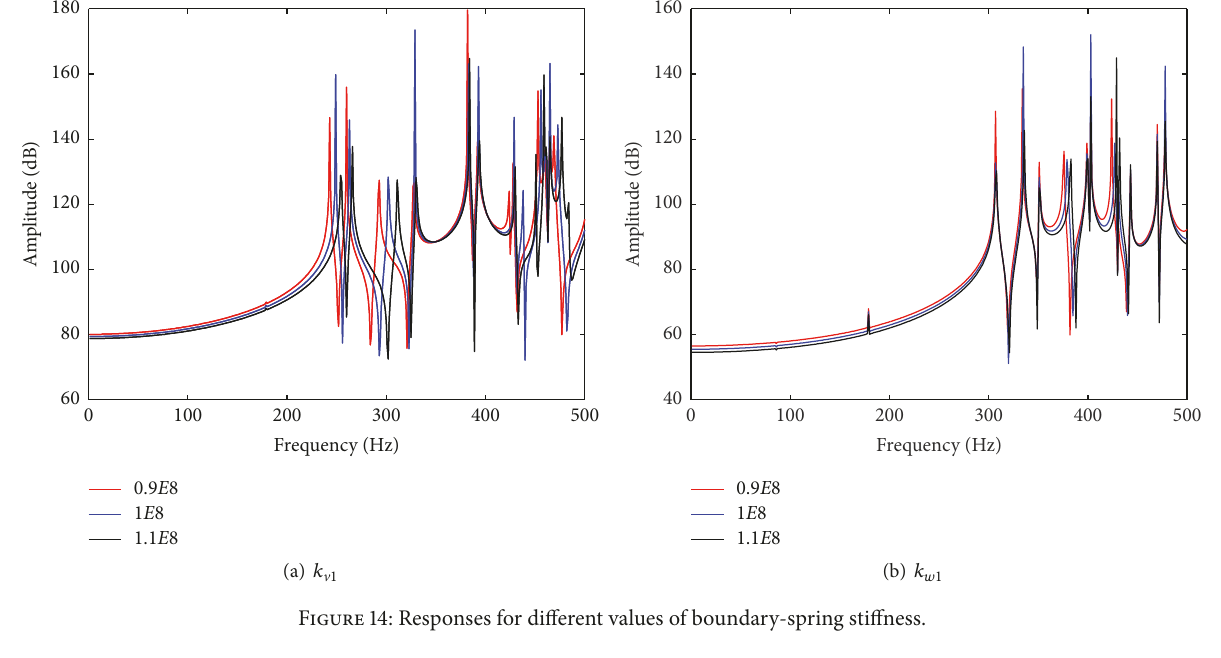
Figure 14: Responses for different values of boundary-spring stiffness.